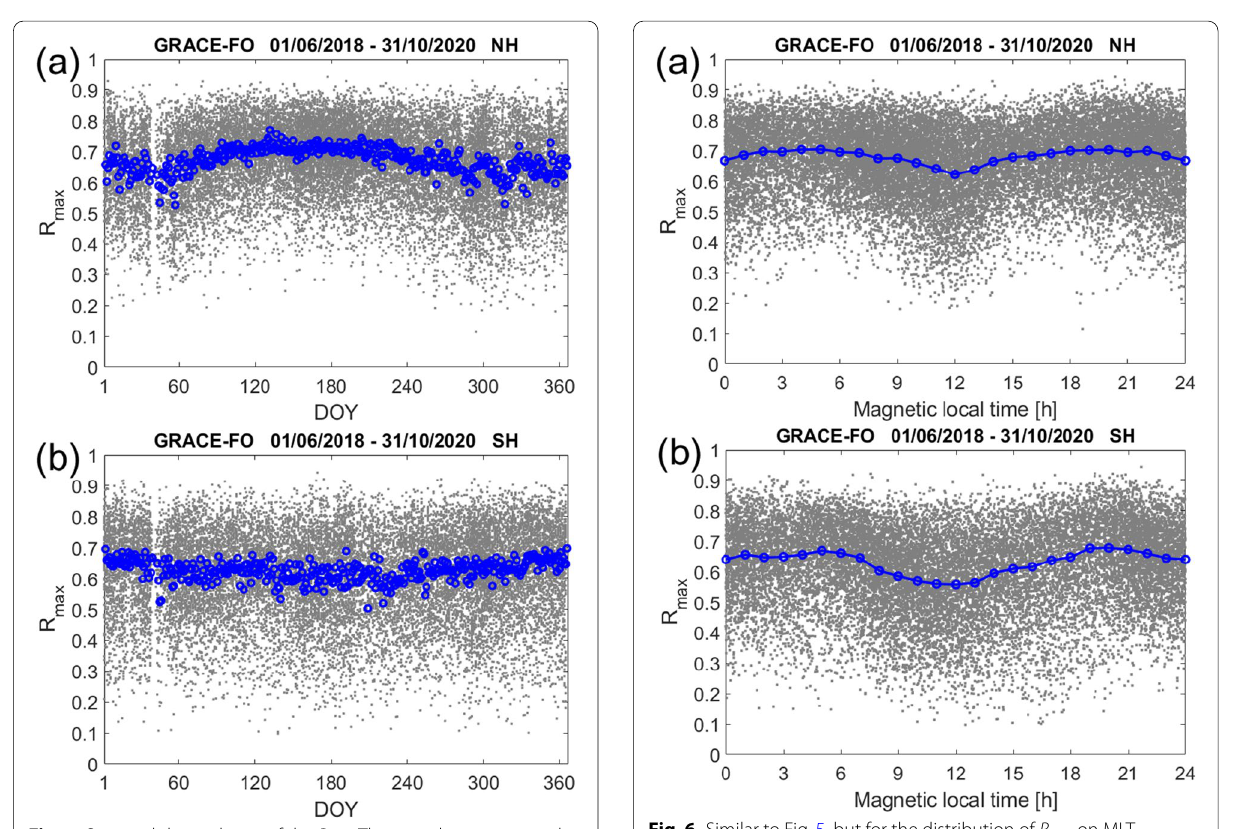
Fig. 5 Seasonal dependence of the R max . The grey dots represent the correlation derived from each high-latitude orbital crossing, and the blue circles represent the median values in each DOY bin